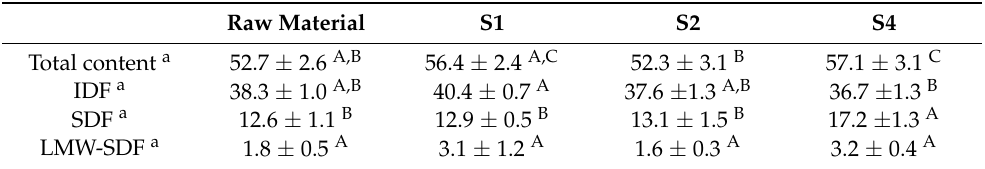
Table 1. Dietary fiber contents (g/100 g dm ; mean value ± standard deviation, n = 3) of enzymatically treated apple pomace (raw and extruded). IDF: insoluble dietary fiber, SDF: soluble dietary fiber, LMW-SDF: low-molecular weight soluble dietary fiber. S1: only transport elements, S2: two reverse elements, S4: two reverse elements and a kneading